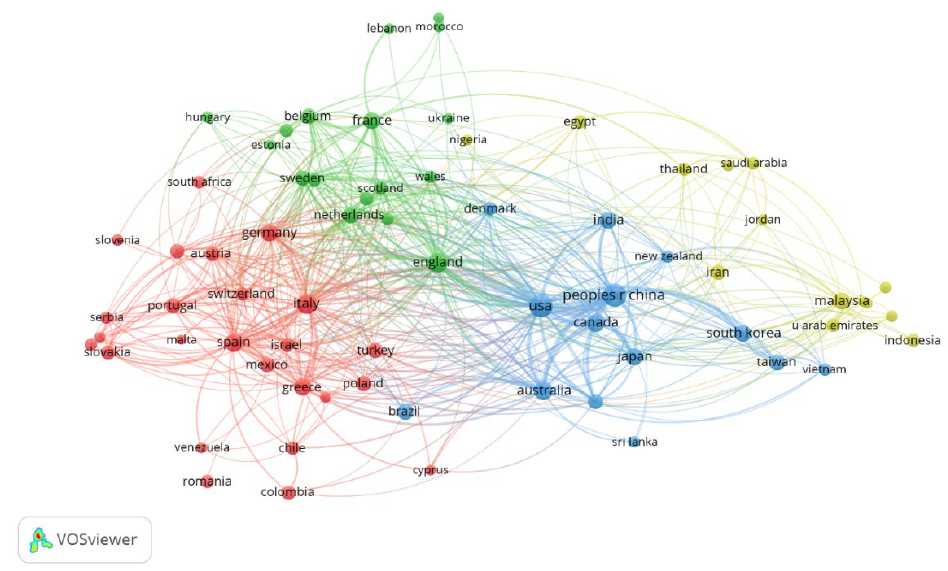
Figure 2. Geographical Distribution Network for Research on Green Roof Analysis .